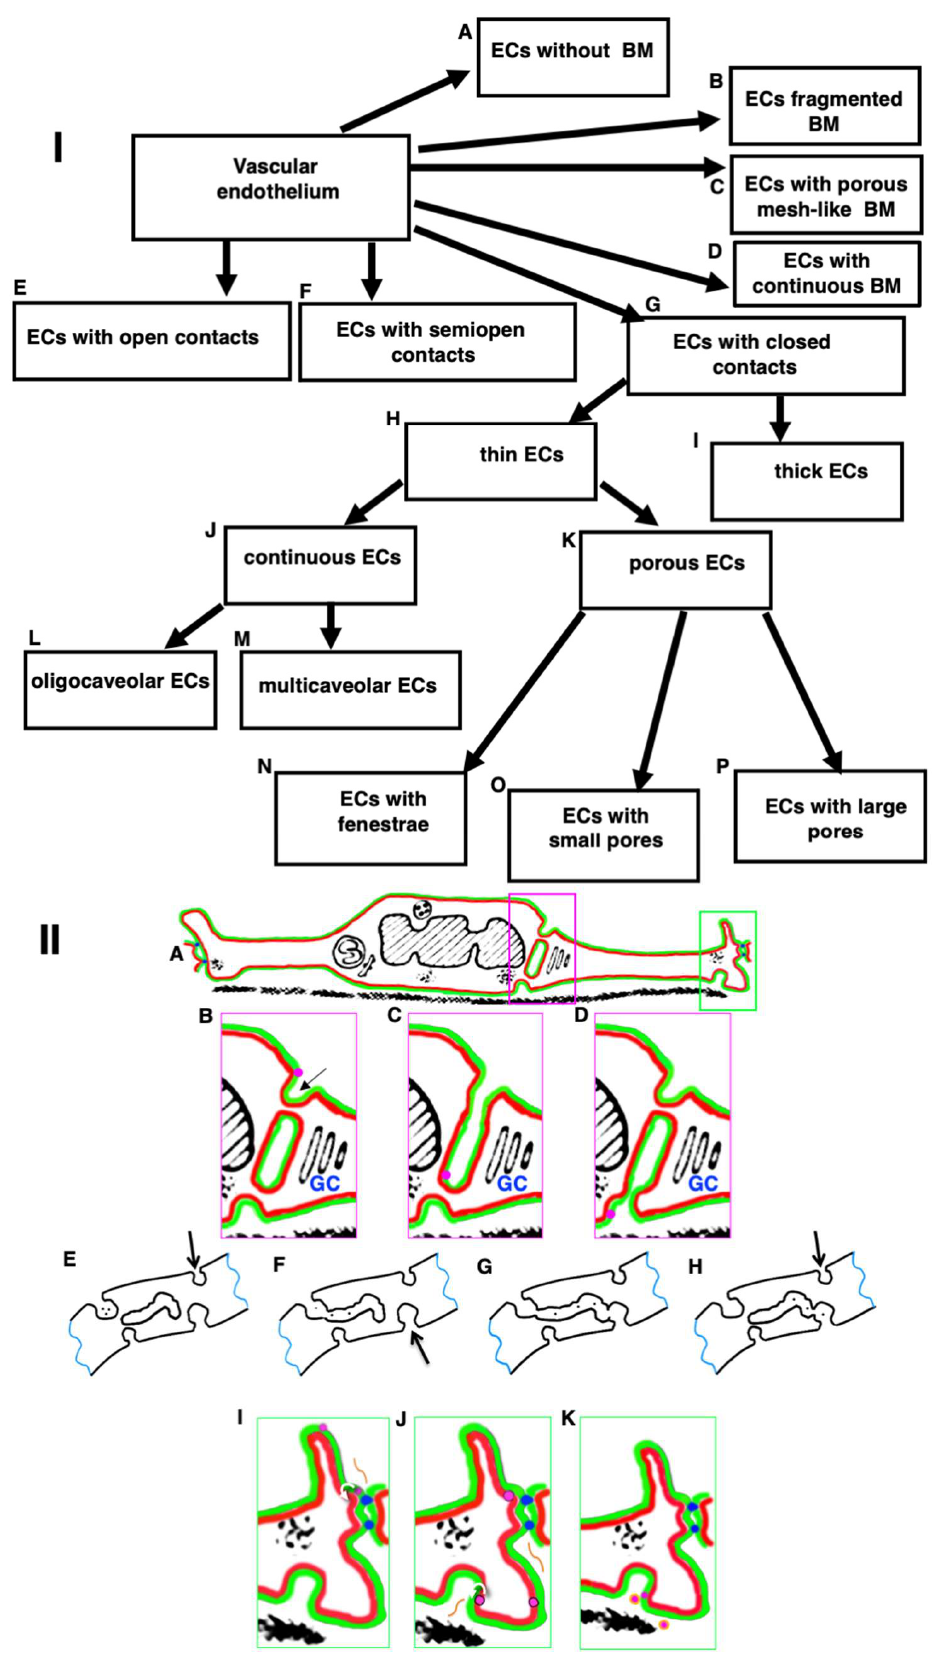
Figure 7. ( I ) Scheme shows principles of the classification of vascular endothelium. ( I : A ) ECs with- out a BM are in lymphatic capillaries. ( I : B ) ECs with a porous BM are in large arteries. ( I : C ) ECs with a continuous BM include all other vessels. ( I : D ) ECs with open contacts are found in the spleen sinusoid. ( I : E ) ECs with semi-open contacts are found in lymphatic capillaries. ( I : F ) ECs with closed contacts are found in all other locations. ( I : G ) Thick ECs are found in high endothelial venules in